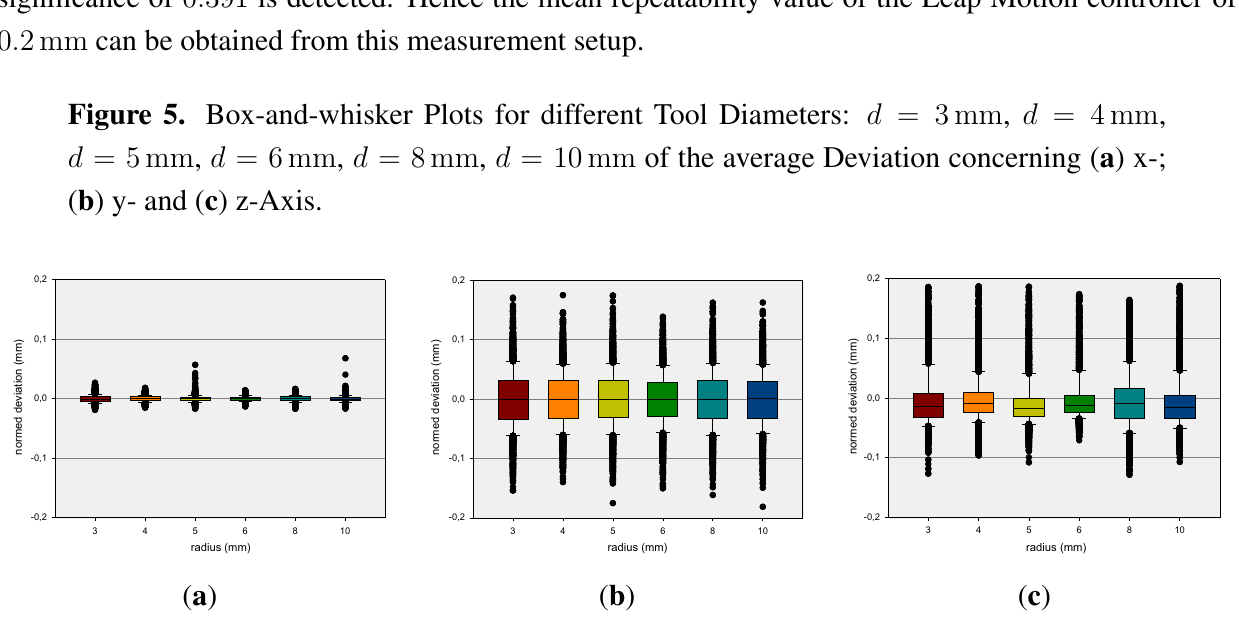
Table 1. Comparison of the Repeatability of Tools with varying